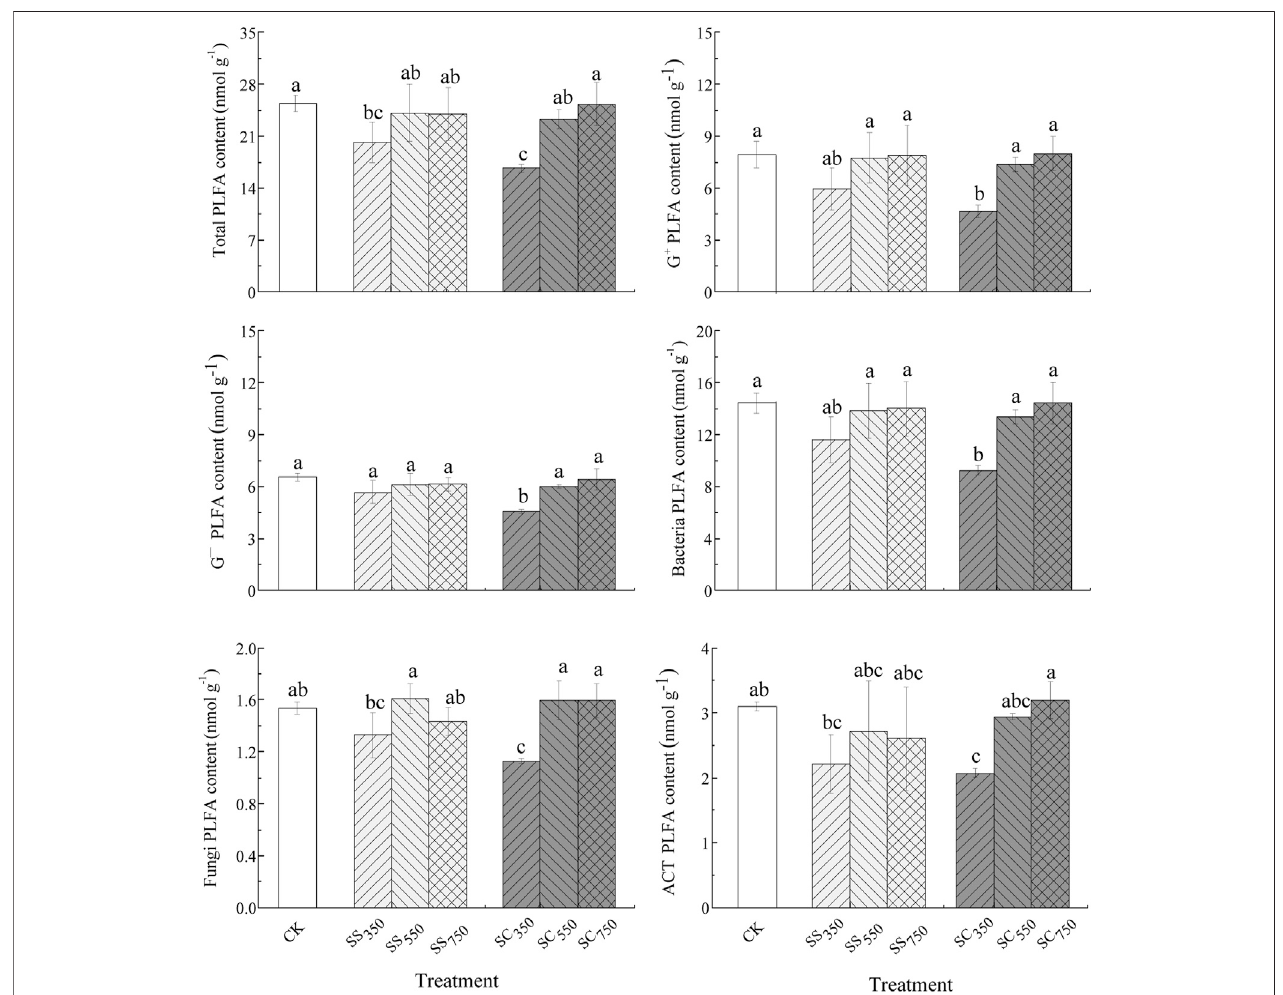
FIGURE3| Microbial PLFA contentofthe differenttreatments. Dataaremean ± standard deviation ( n (cid:2) 3).Differentletters indicate signi fi cantdifferences between the treatments ( p < 0.05).